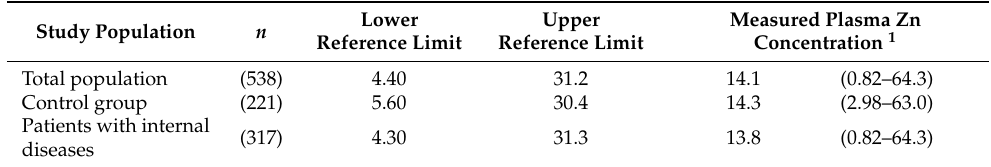
Table 1. Lower and upper reference limits for the plasma Zn concentrations ( µ mol/L) of the hospital- ized horses and ponies, as well as the measured values ( µ mol/L; median (minimum–maximum)) of the total study population and the two main